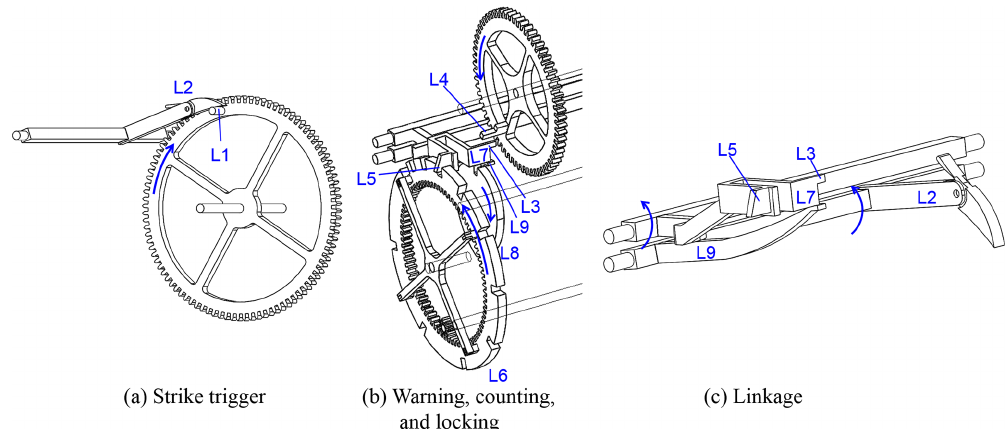
Figure 9. Structure and operation of the N2 trigger